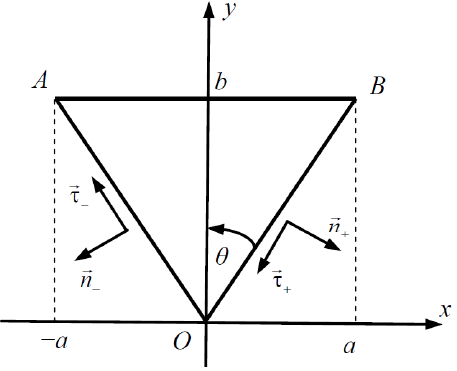
Figure 1. Triangular